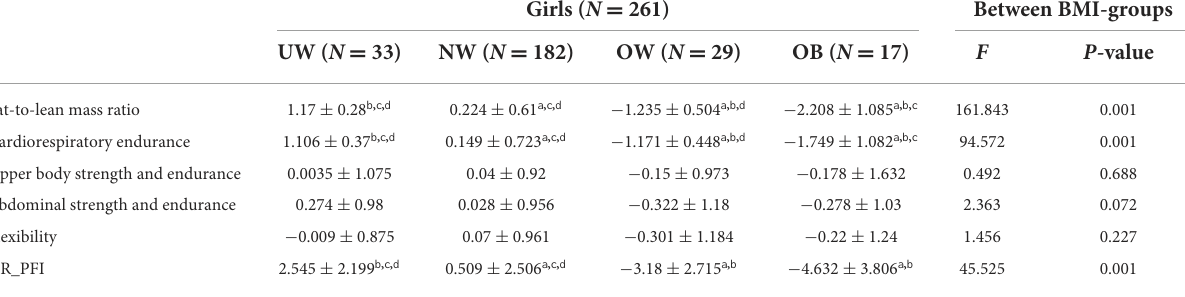
TABLE 5 Mean Z- score of health-related physical fitness components of female participants by BMI category.